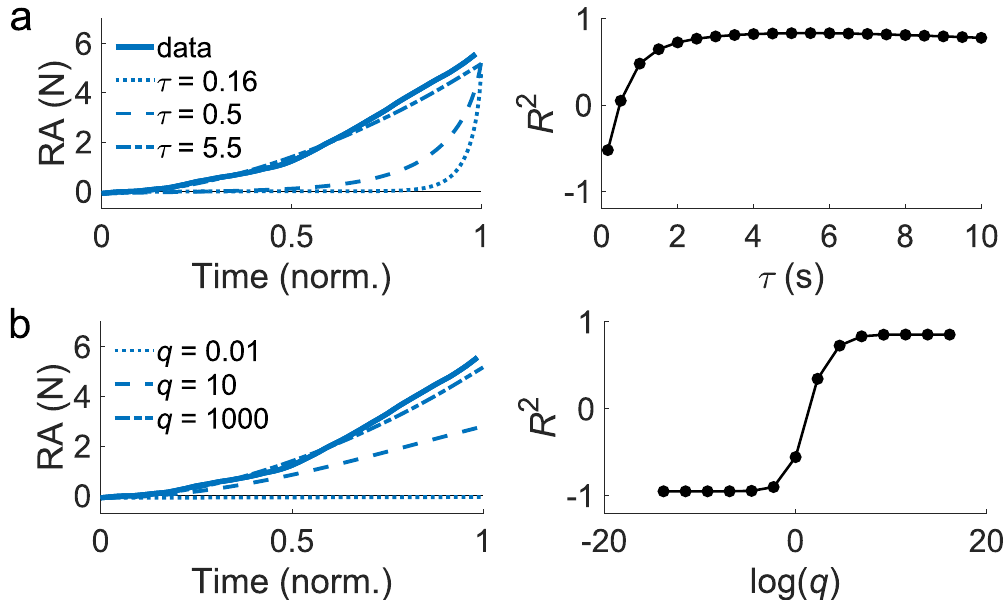
Figure 3. The values of the time constant τ and the weight on the state cost q changed the variability in the data explained by the model. ( a ) Time-series of the RA in the point-to-point task (pure flexion target) for different values of τ . The data is charted alongside for reference. The weight on the state cost q = 1000 was kept constant. R 2 increased with larger τ , plateauing at 5.5 s. ( b ) The weight on the state cost q was varied while τ = 5.5 s was kept constant. R 2 tended to increase with greater weight on the state cost q